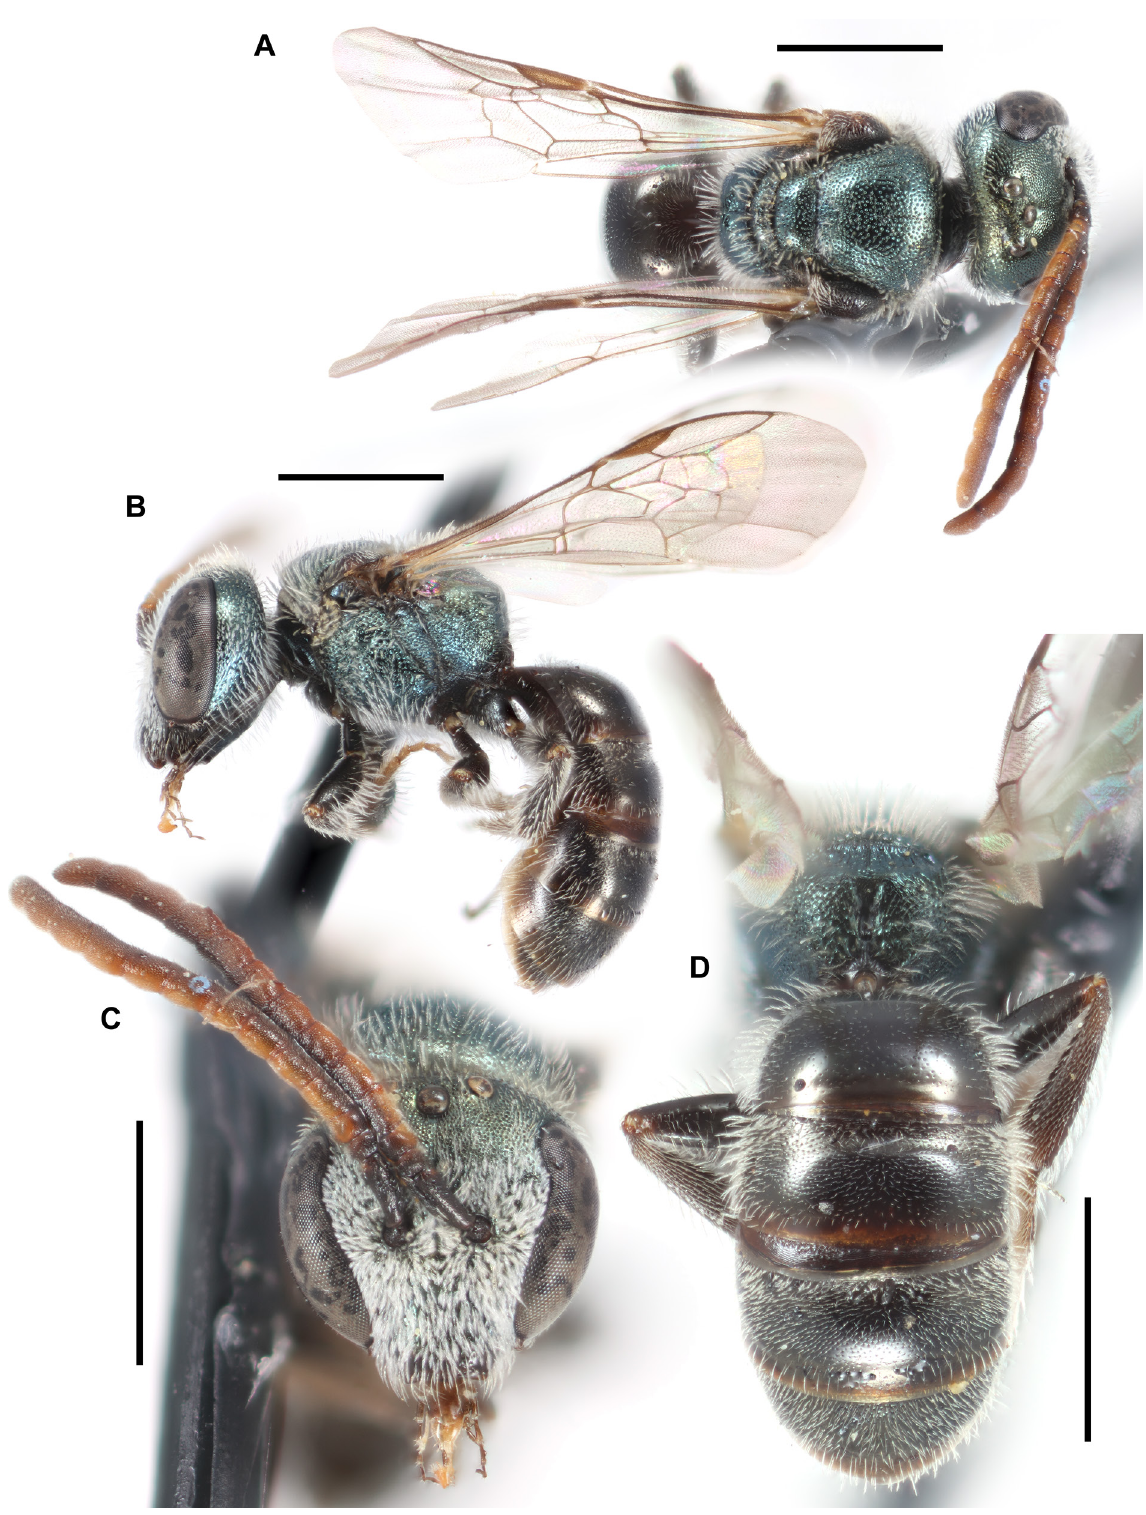
Fig. 74. Lasioglossum ( D .) tegulariforme (Crawford, 1907), ♂ (reproduced from Gardner & Gibbs 2022) (WRME). A . Dorsal habitus. B . Lateral habitus. C . Face. D . Metasoma and propodeum. Scale bars = 1